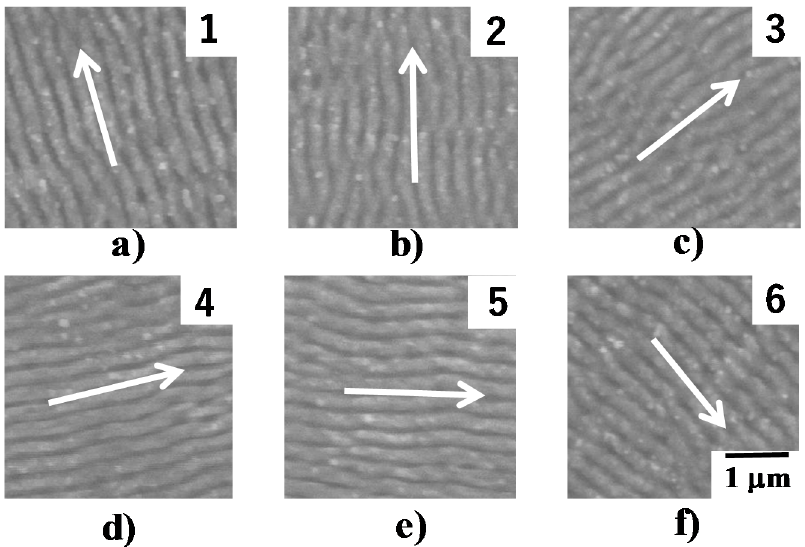
Figure 2. Six nanotextures formed onto the stainless steel plates by the optical path control. Directivity of the nanotextures is controlled to rotate from ( a – f ). In the following, each nanotextured segment with the specified orientation was identified by each number; e.g., a nanotextured segment in Figure 2a was identified by No. 1.